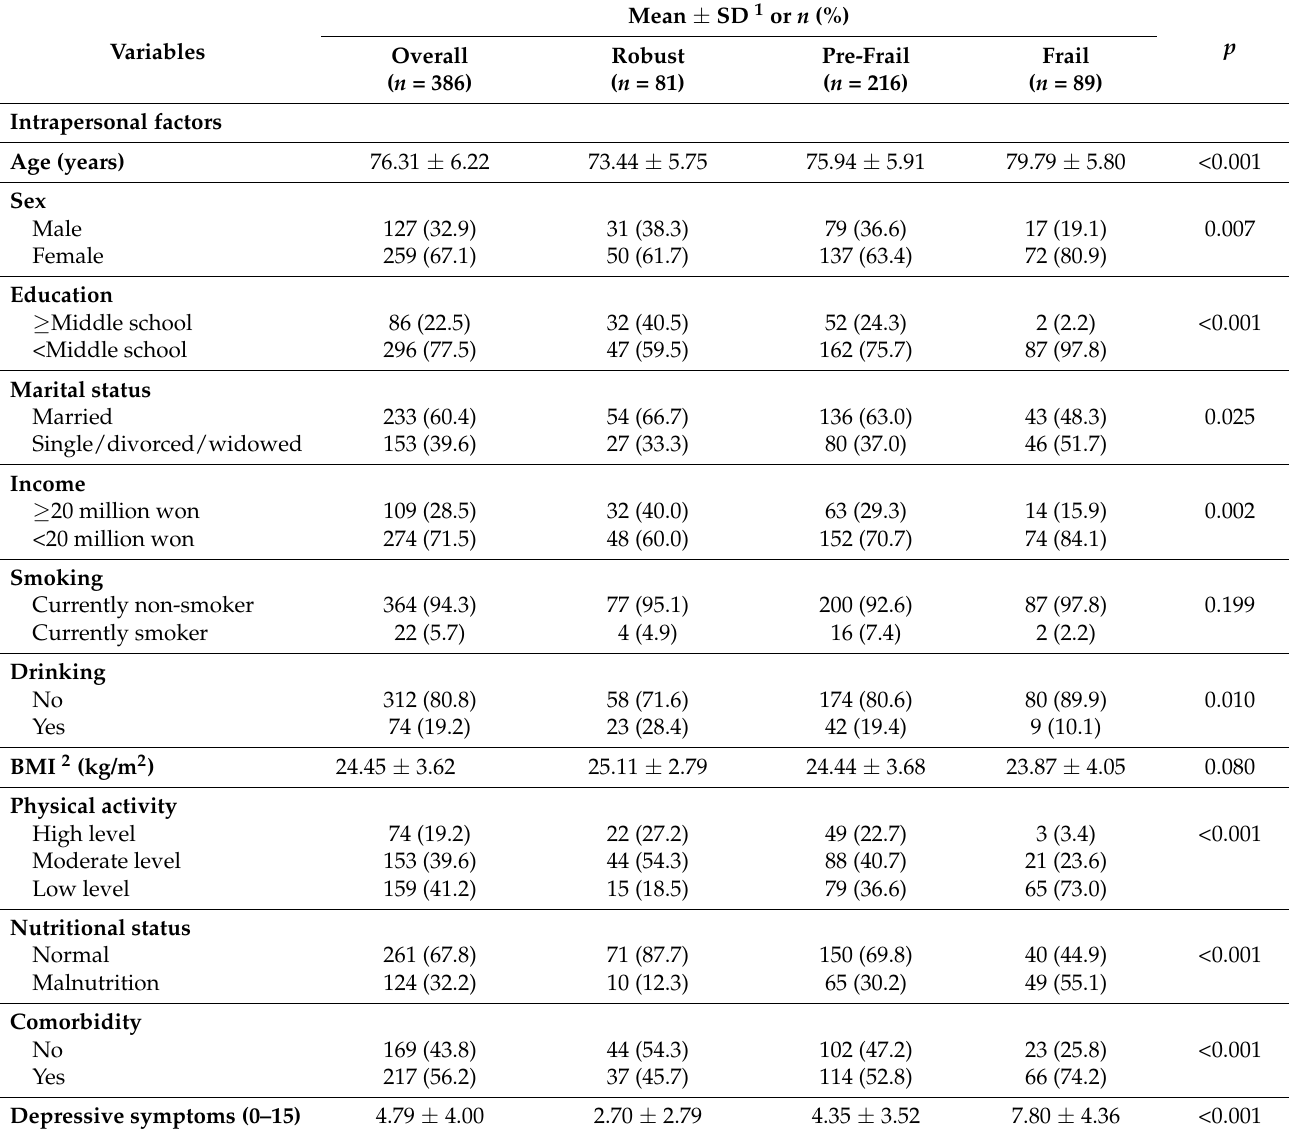
Table 1. General characteristics of participants based on frailty status ( n =